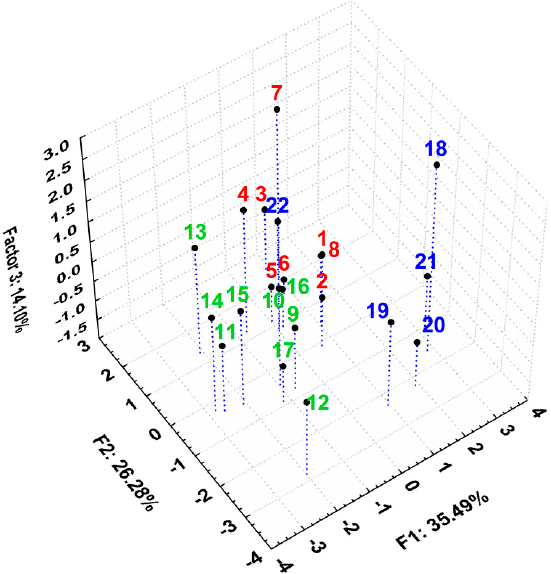
Figure 7. 3D scatterplot of the scores for the first three principal components after applying PCA on all the discussed parameters, describing biological activity for all the studied compounds.